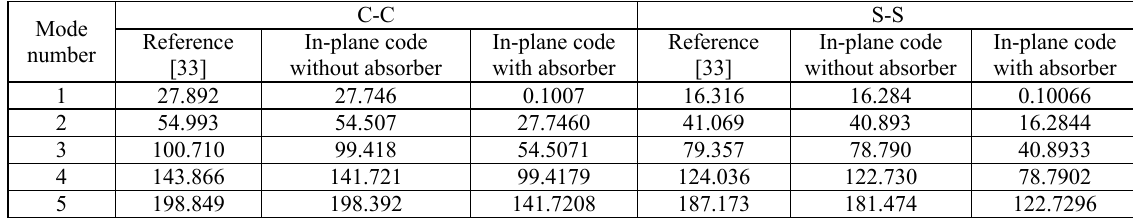
Table 4. Natural frequencies of curved beams (Hz) with C-C and S-S boundary conditions. C-C S-S Mode Reference In-plane number